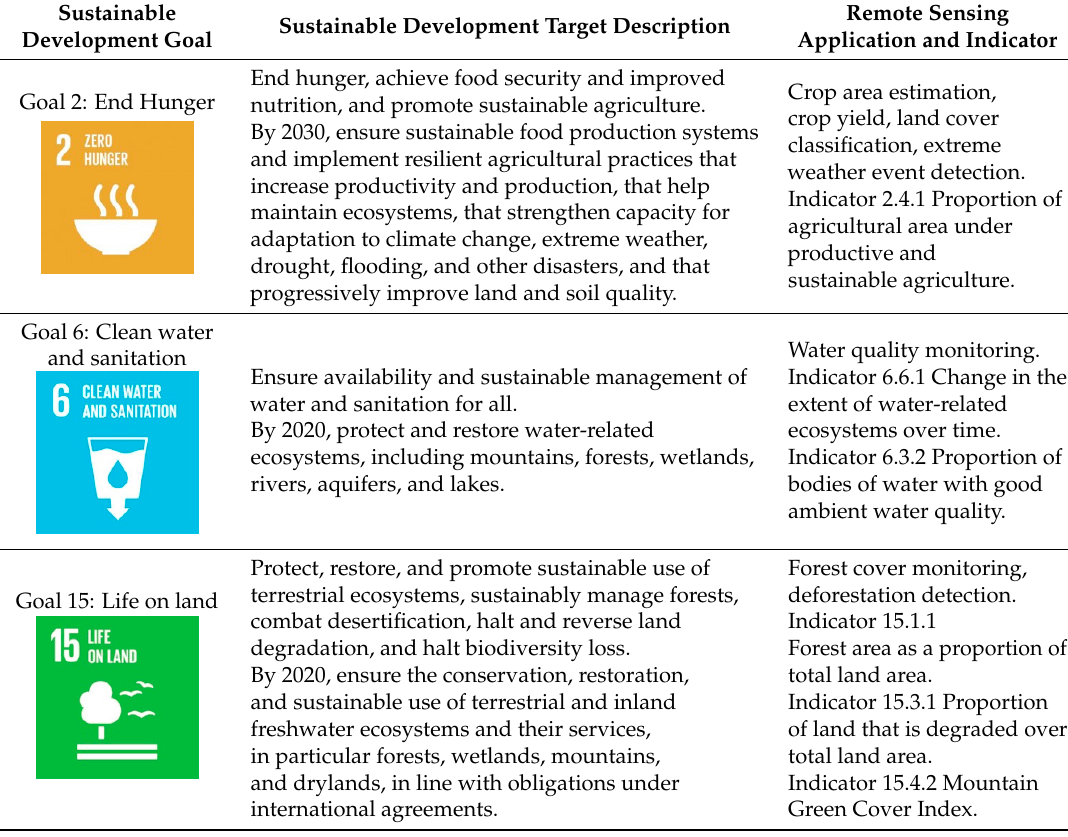
Table 1. Remote sensing data, as used to measure UN Sustainable Development Goals.